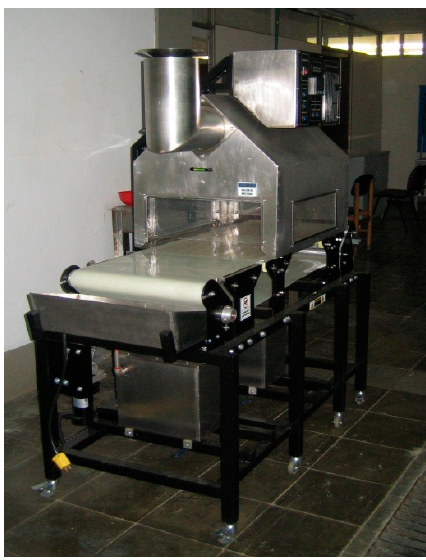
Figure 2. Refractance window equipment for drying guava slices.